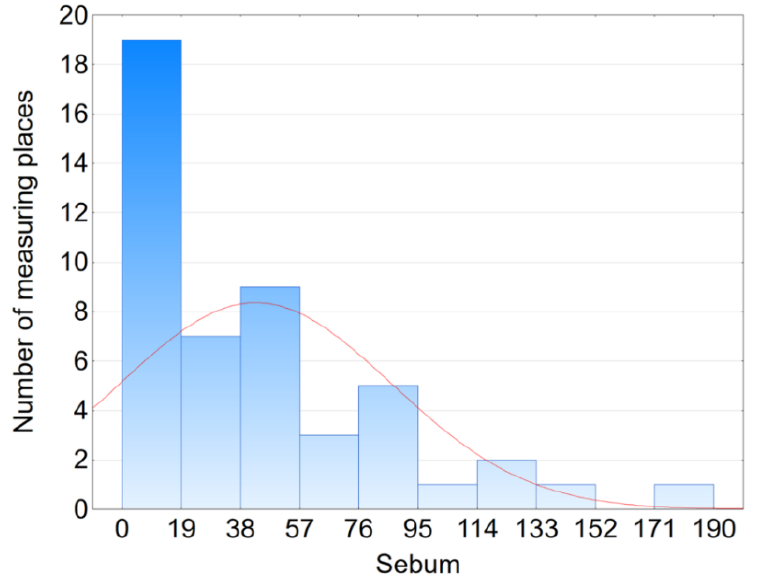
Figure 1. Histogram of the amount of skin sebum.